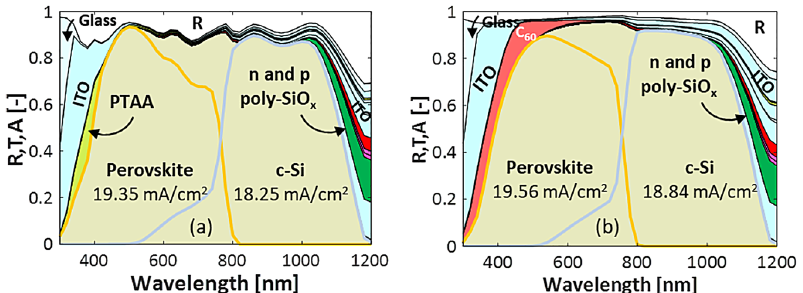
Figure 4: Reflectance and absorptance of 4T perovskite/c-Si tandem solar cell with (a) fl at top cell as in the study by Zhang et al. [59] (see Figure1(f))or (b)texturedtop cellas inthestudy bySahliet al.[8] (Figure1(f)but withtexturedtopcell as inFigure1(b)).The c-Sibottomcell is passivated with poly-SiO x CSPCs.